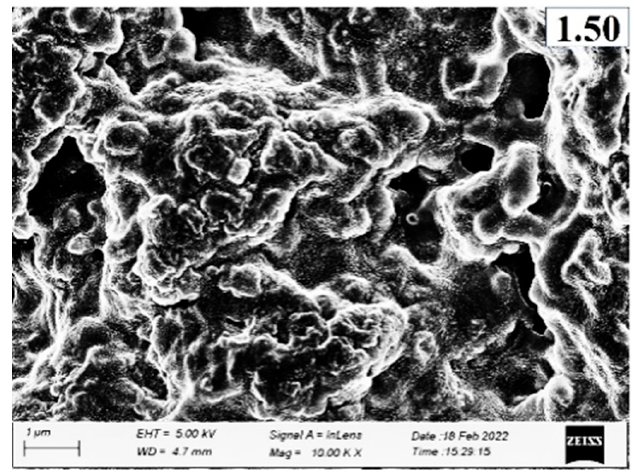
Figure 7. Electron microscopic images of surimi gels with different concentrations of PPE added (0.25 – 1.5%, w / w ) at magnification of 10,000×. (Con) surimi without PPE; (0.25) surimi with 0.25% PPE added; (0.50) surimi with 0.50% PPE added; (0.75) surimi with 0.75% PPE added; (1.00) surimi with 1.00% PPE added; (1.25) surimi with 1.25% PPE added; and (1.50) surimi with 1.50% PPE added.